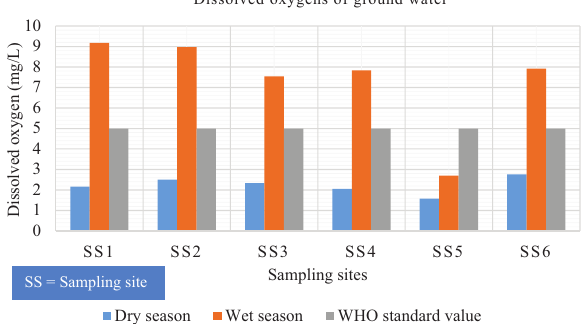
Figure 6 . Seasonal variation in the dissolved oxygen of groundwater quality in the study area